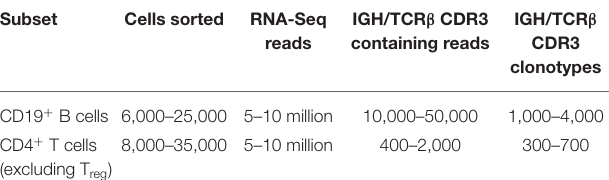
TABLE 1 | CDR3 counts from sorted T and B cells from B16F0 melanoma. Subset Cells